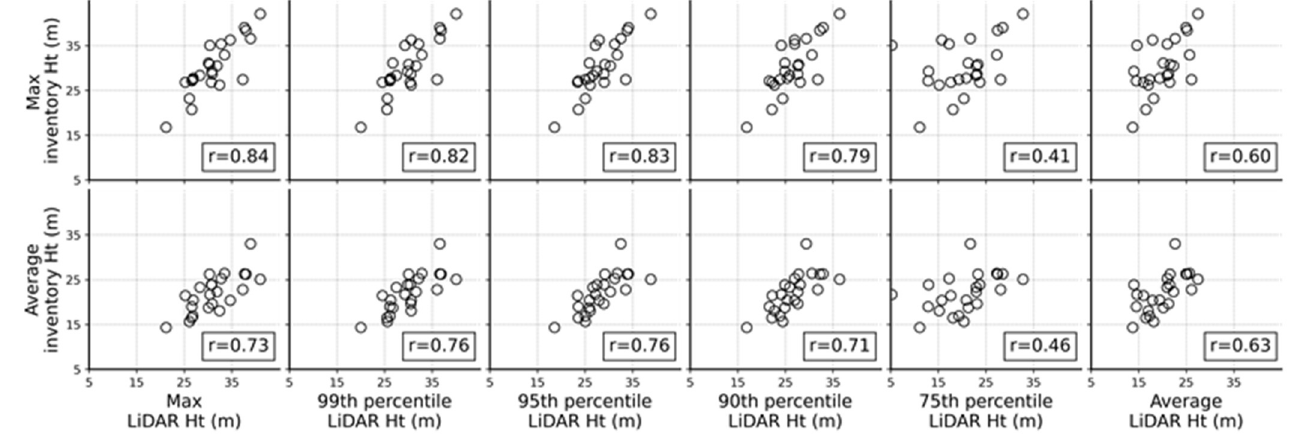
Figure 10. Correlation between LiDAR and inventory height metrics. LiDAR data in 2017–2020 and inventory data in 2013–2017 were used. Forest plots have positional uncertainty approximately less than 0.1 m ( n = 24). Ht: height.